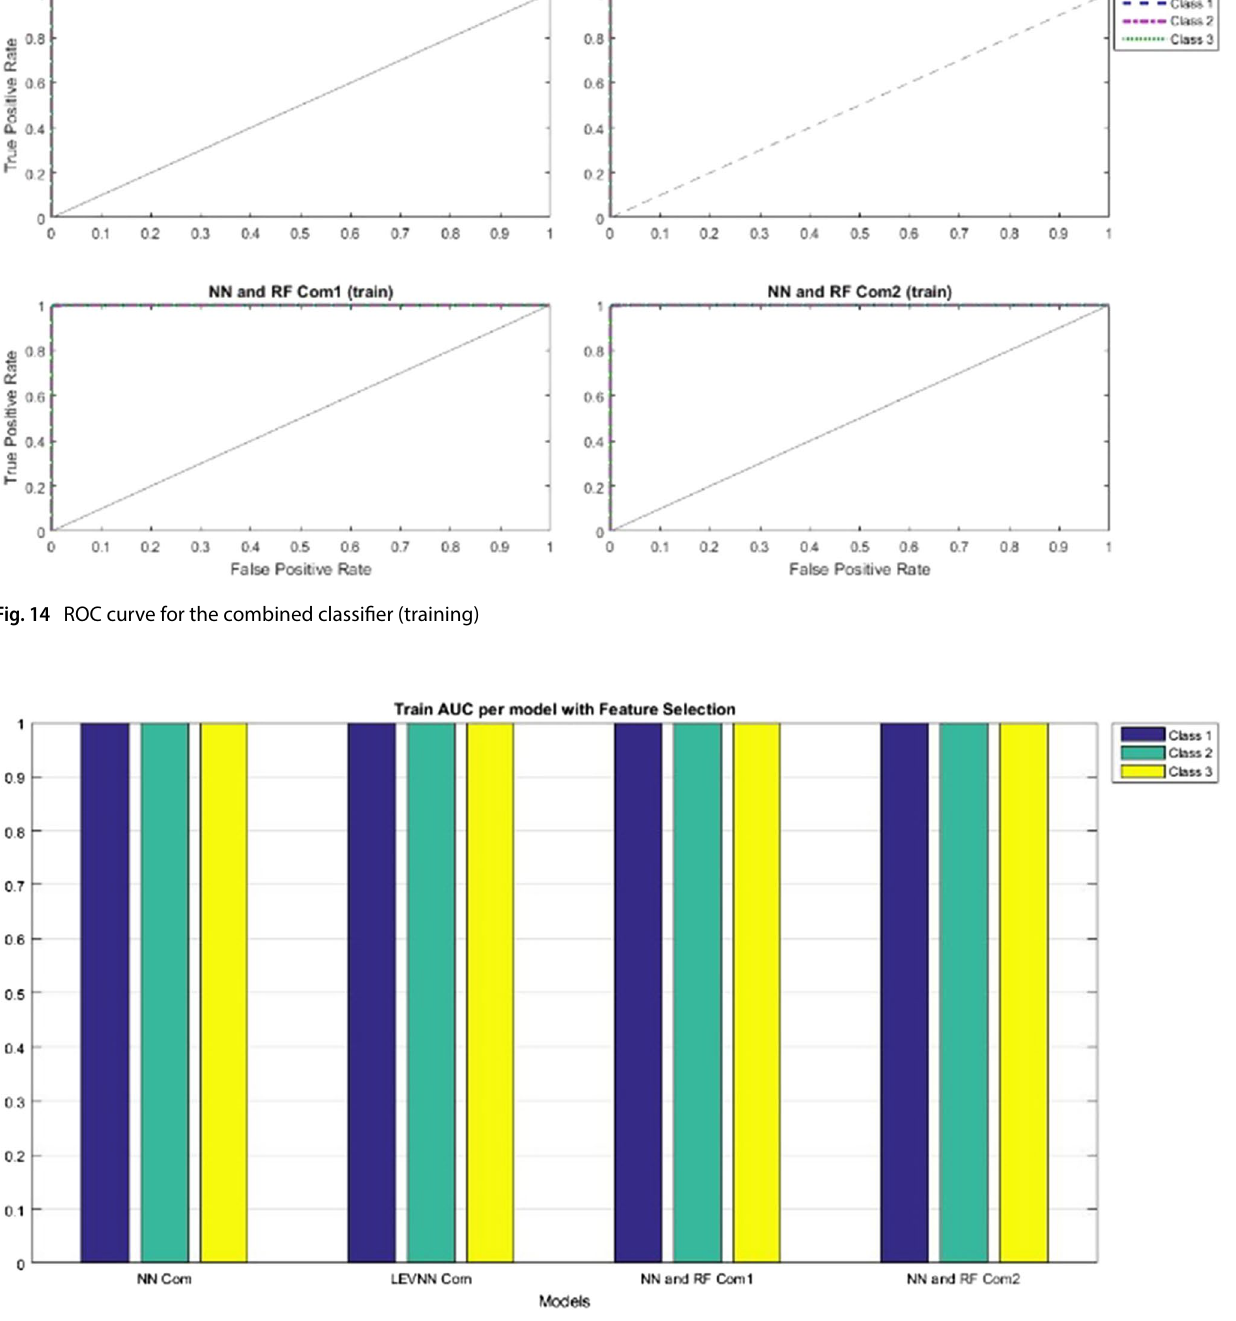
Fig. 15 AUC plot for the combined classifier